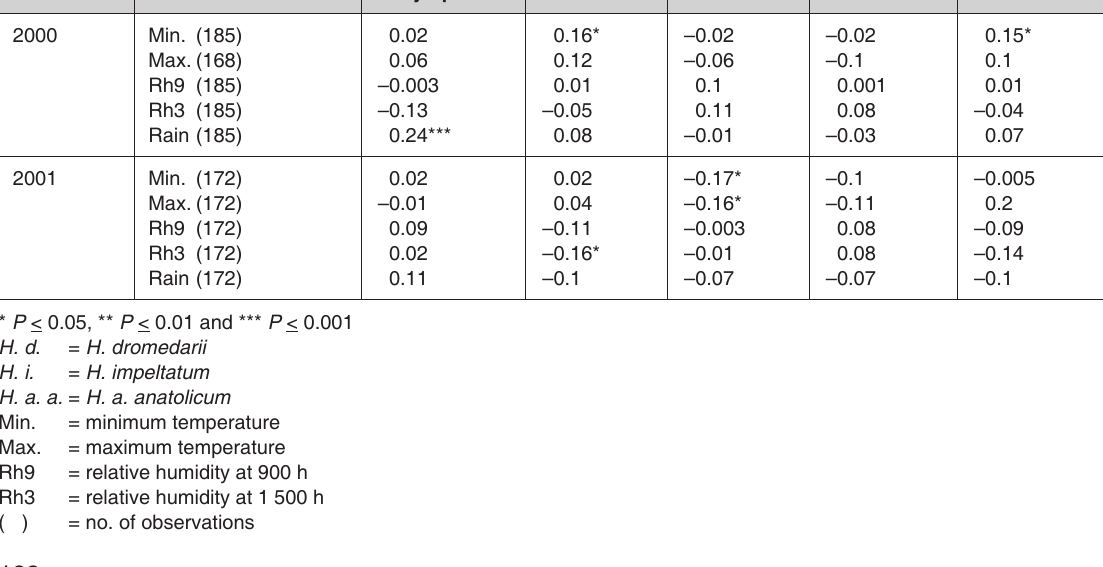
Females : grey 108, brown 74 Males: grey 50, brown 17